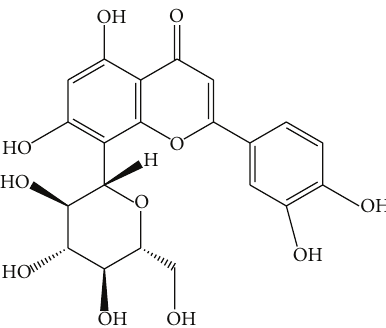
Figure 1: Chemical structure of